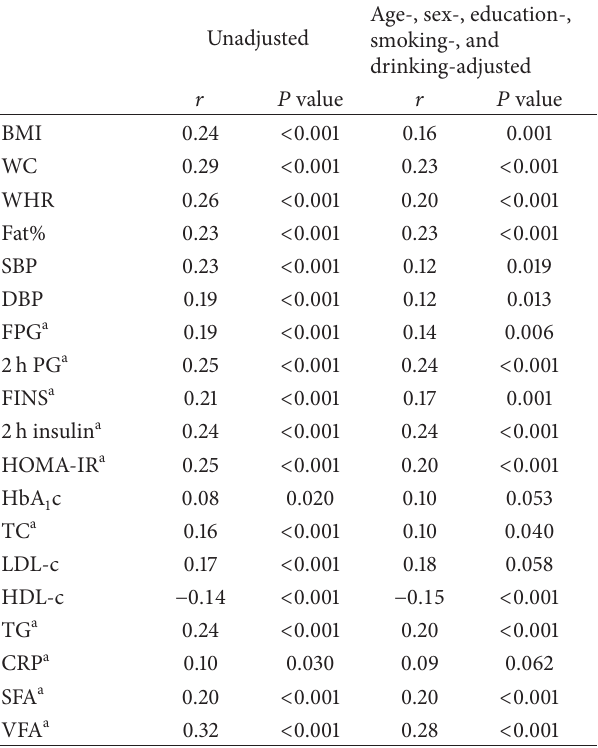
Abbreviations as in Table 1. Coefficients were performed using Pearson’s correlation